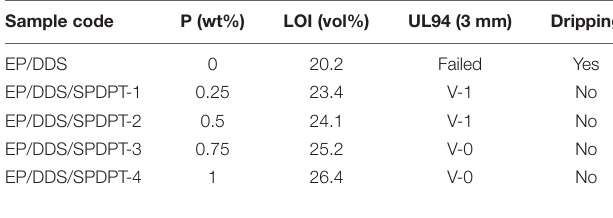
TABLE 4 | LOI and UL-94 test results of epoxy thermosets.